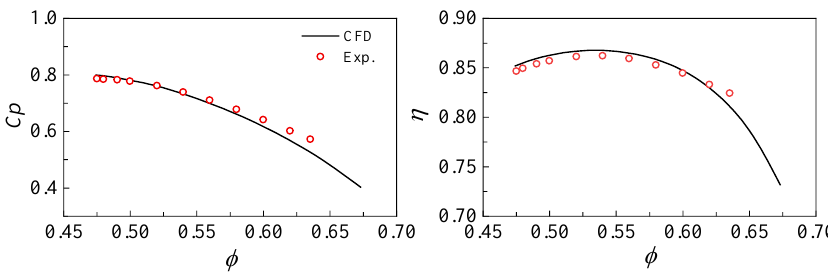
Figure 5. Comparison of stage characteristics between the experiment and numerical simulation.